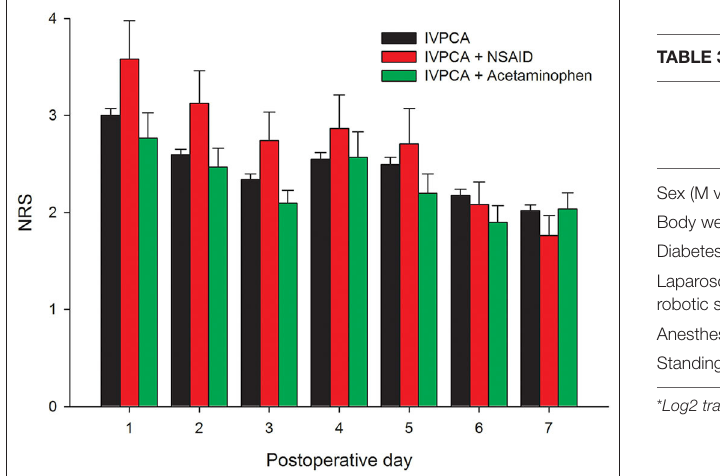
FIGURE 1 | Daily mean pain scores during the first postoperative week after liver cancer surgery.